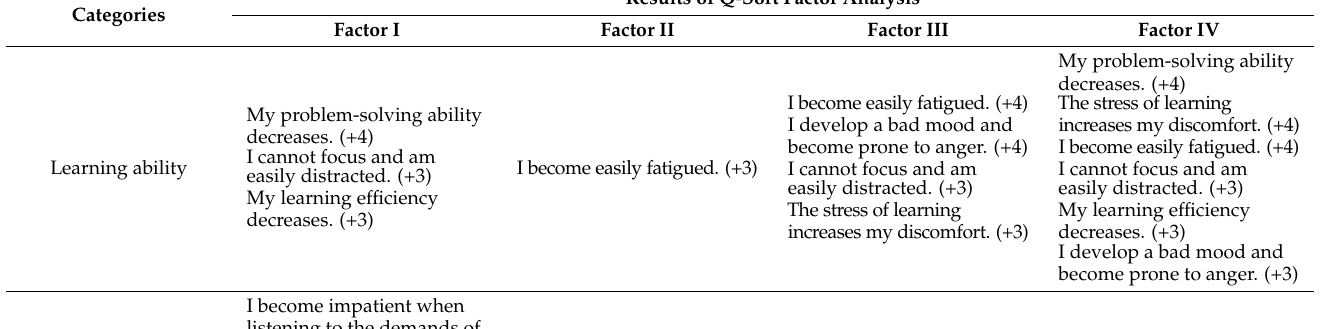
Table 2. Characterizing statements of the four